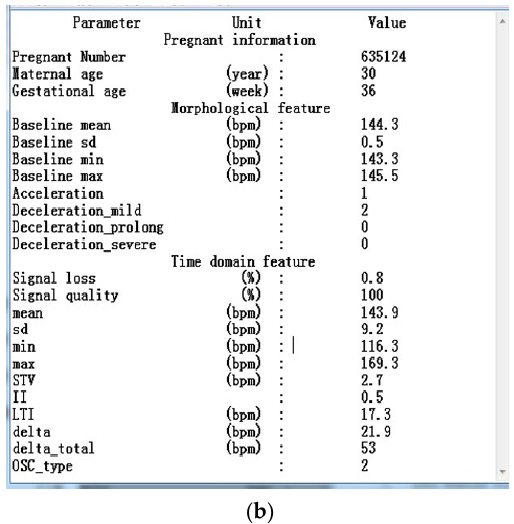
Figure 4. The results of the feature extraction algorithm of No. 1001 FHR recording (internel database number) using CAS-FHR. ( a ) The results are viewed in the software interface, inlcuding the morphological, time and frequency domain and nonlinear features; ( b ) The results are saved in txt format for further analysis.